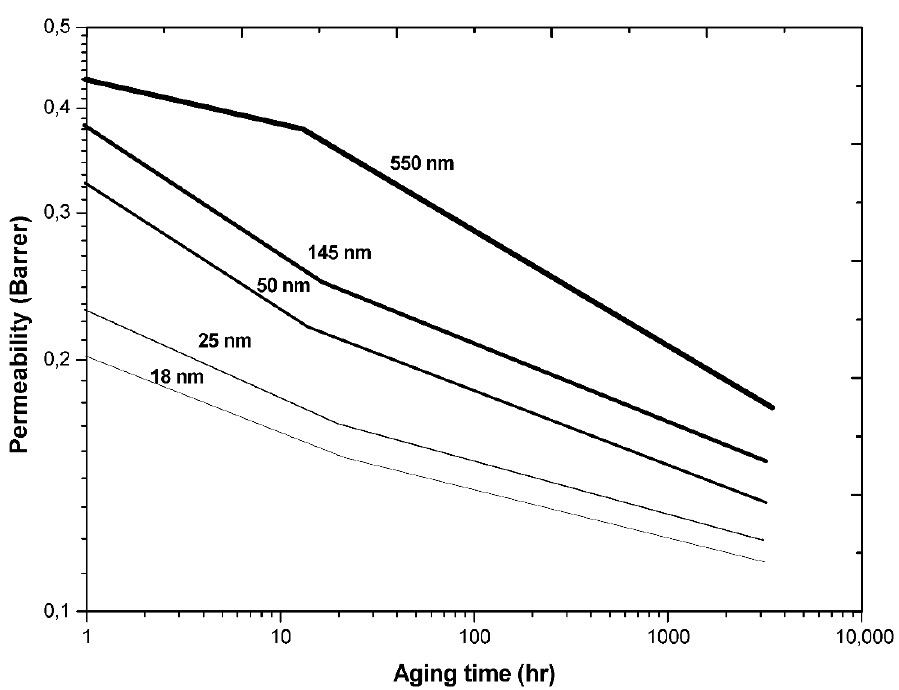
Figure 7. Effect of physical aging on CH 4 permeability in Matrimid ® films as a function on time and thickness at 35 °C and 2 atm (Adapted from Rowe and co-workers, 2009).